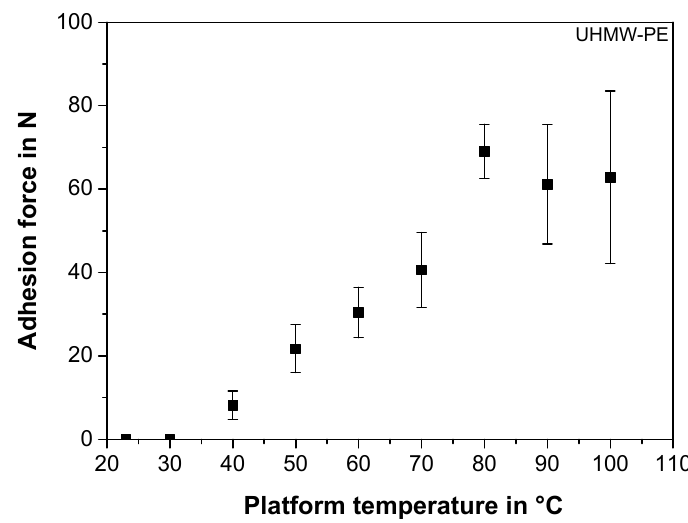
Figure 4. The adhesion force between the printed PP-composite and the ultra-high-molecular-weight polyethylene (UHMW-PE) build platform as a function of the platform temperature, for a constant thickness of the first layer of 0.2 mm.